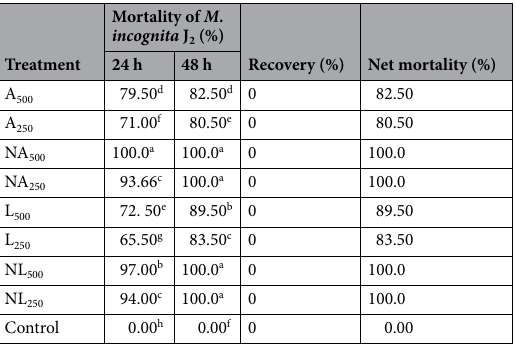
Table 2. Nematicidal activity of A. annua and L. sativum extracts and their nano-formulations against M. incognita juvenils mortality. Means followed by the same letter(s) are not significantly (P < 0.05) different.